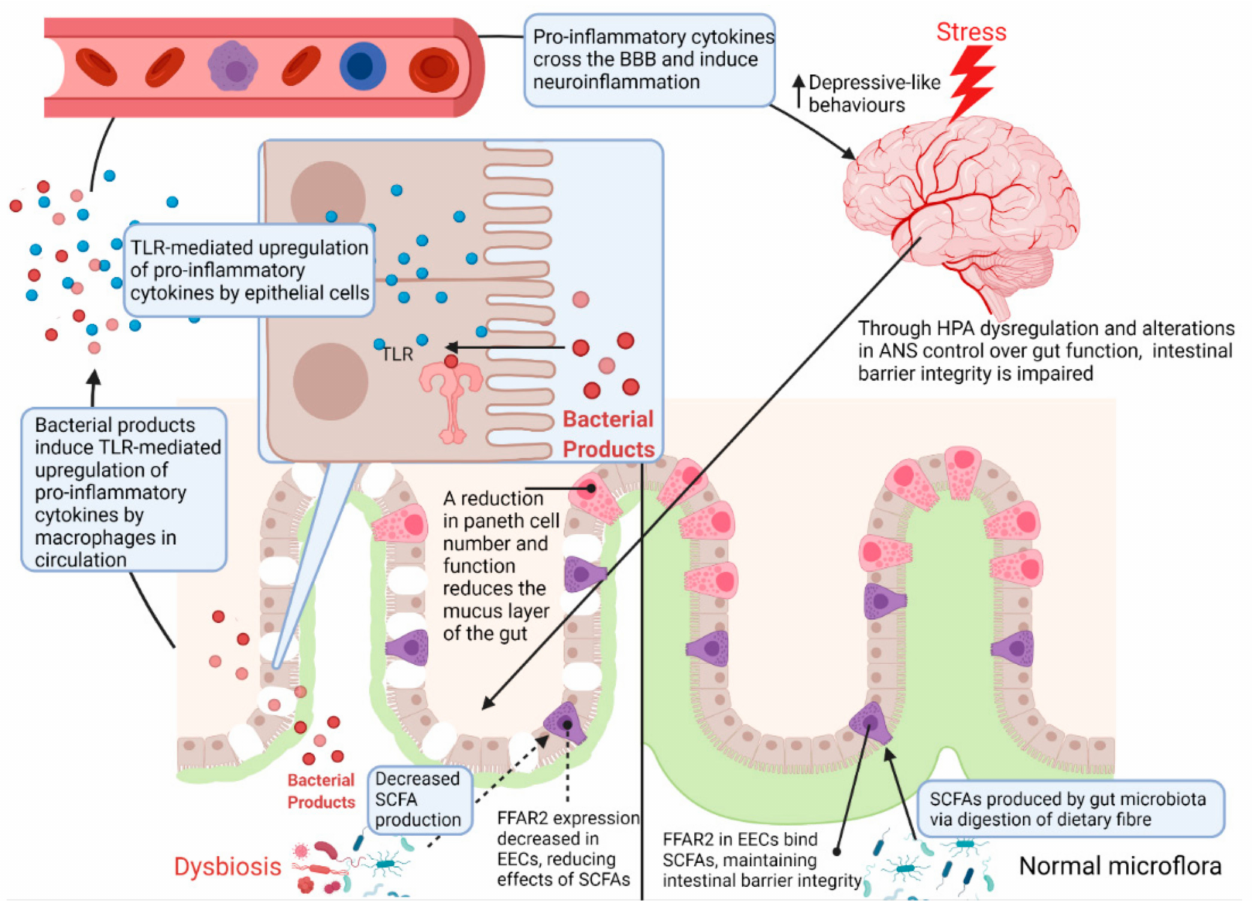
Figure 5. Regulation of the intestinal barrier by chronic stress. Chronic exposure to stress results in dysregulation of the HPA axis and ANS control over gut function [2,6]. As a result, Paneth cell number and function is reduced, contributing to microbial dysbiosis through a reduction in the mucus layer of the gut [29,76]. This reduction of the mucus layer also allows bacteria and their associated products to reach the gut epithelium [49]. Since dysregulation of the HPA axis results in a decrease in tight junction proteins, bacterial products such as LPS can reach epithelium, the lamina propria and circulation where a TLR-mediated pro-inflammatory response is initiated by macrophages [49]. These pro-inflammatory cytokines ultimately travel to the brain where they can cross the blood–brain barrier and increase neuroinflammation, eliciting depressive-like behaviours [2,49]. HPA—hypothalamic– pituitary–adrenal axis; ANS—autonomic nervous system; SCFA—short chain fatty acids; FFAR2—free fatty acid receptor 2; EEC—enteroendocrine cell; TLR—Toll-like receptor; BBB—blood–brain